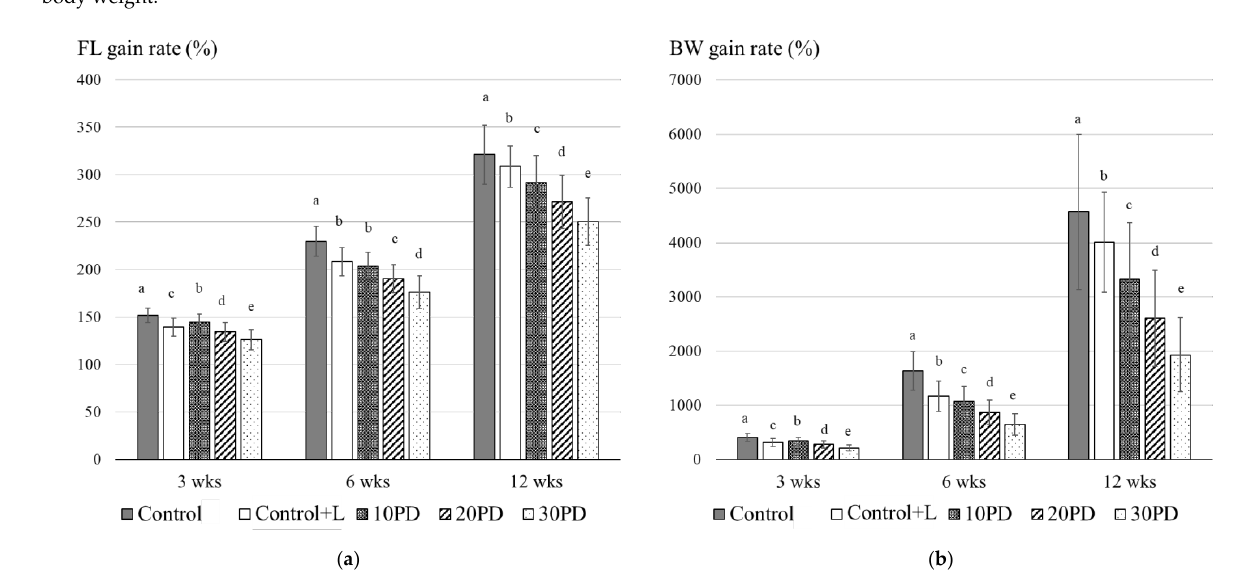
Figure 1. Fork length gain rate ( a ) and body weight gain rate ( b ) of yellowtail in feeding trial 1. Bars indicated S.D. Different letters indicate statistically significant differences according to Kruskal – Wallis test and Mann – Whitney test with Holm’s correction for post hoc comparison ( p < 0.05). Abbreviations: FL, fork length; BW, body weight. Table 7. Growth of juvenile yellowtail in feeding trial 2.